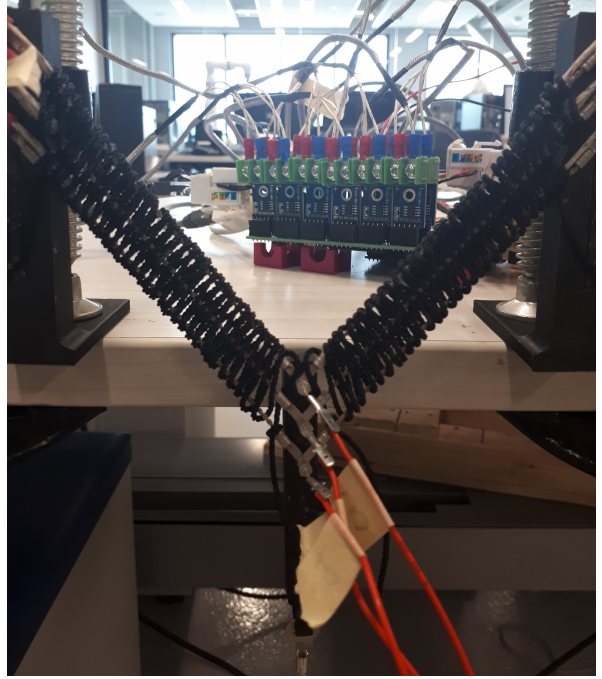
Figure 6. Actuator configuration for the contraction period characterisation